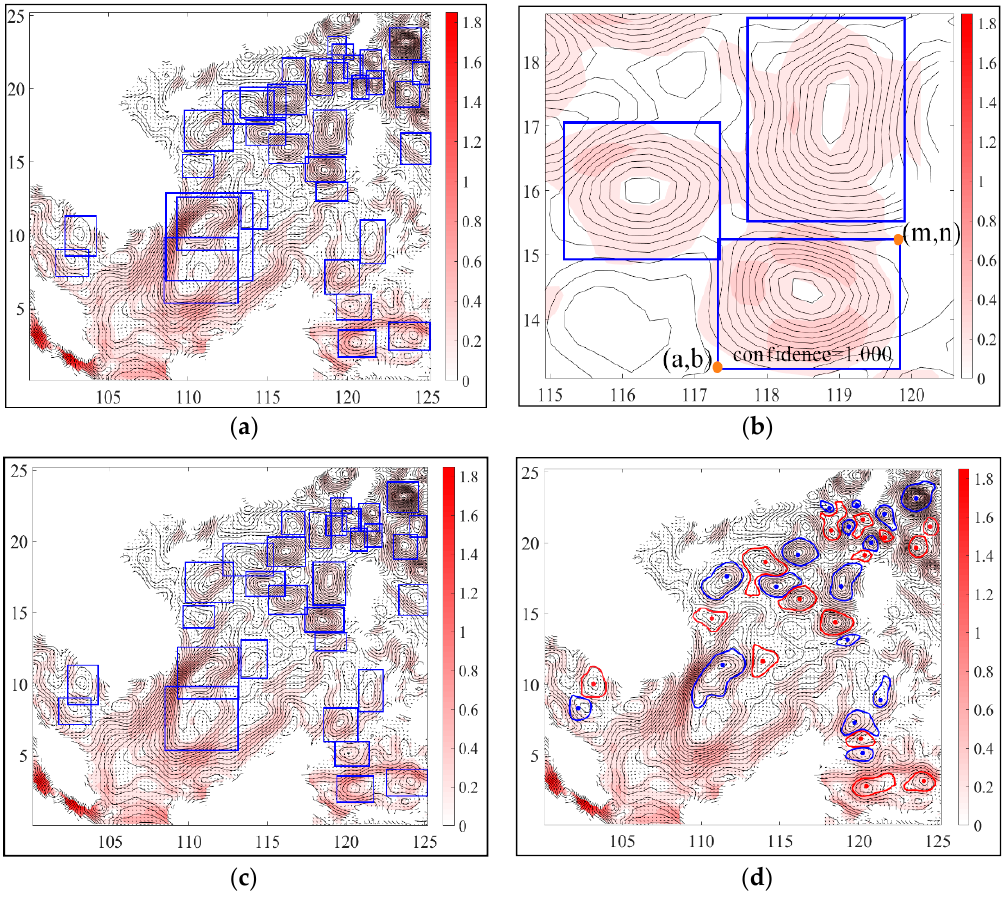
Figure 7. ( a ) The raw output of the model built in this paper; ( b ) example for the output of bounding box; ( c ) the eddy detection results processed by the non-maximum suppression (NMS) algorithm; and ( d ) the final visualization result after eddy center positioning and contour output (the cyclone eddies are marked in blue points and blue curves, and the anticyclone eddies are marked in red points and red curves). Color map and contours (black lines) represent the geostrophic velocity speed [m/s] (Equation (1)) and sea level anomaly [cm], respectively.